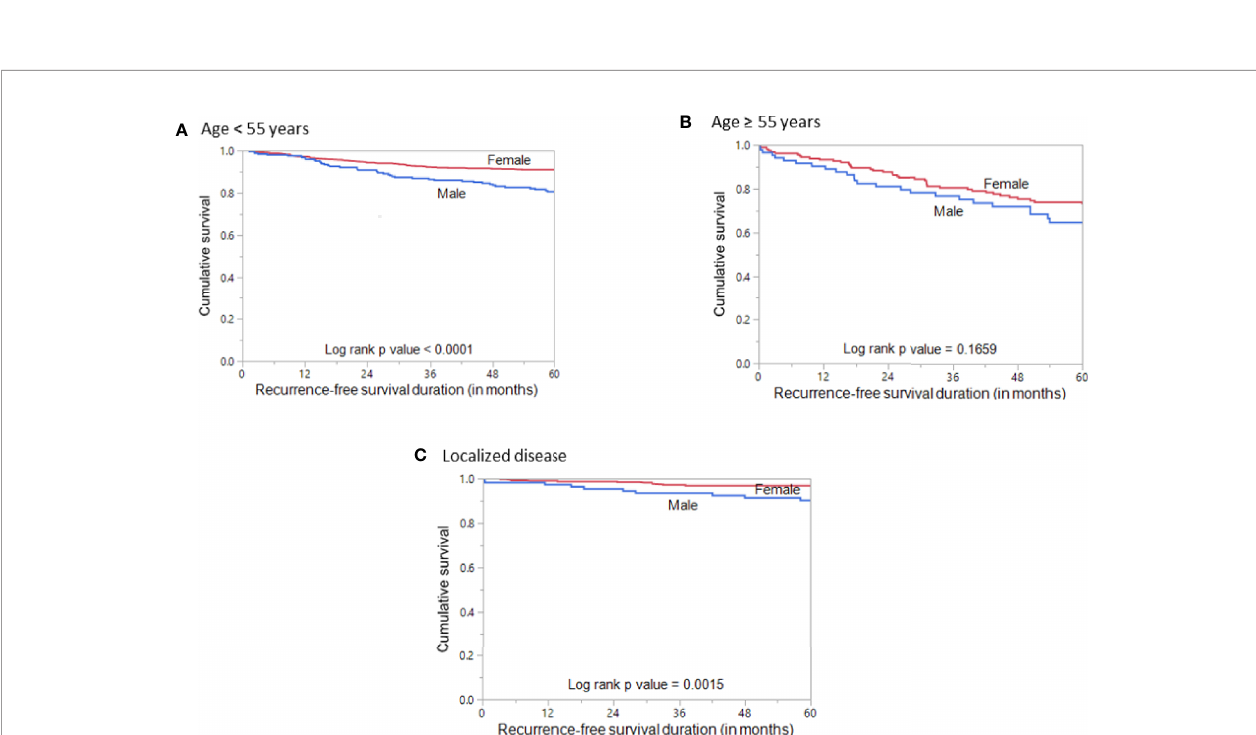
FIGURE 3 | Recurrence-free survival strati fi ed by age and disease localization. (A) Kaplan – Meier survival curve showing poor recurrence-free survival in male sex compared to female sex in patients aged < 55 years ( p < 0.0001). (B) Kaplan – Meier survival curve showing no signi fi cant difference in recurrence-free survival between male and female sex in patients aged ≥ 55 years ( p = 0.1659). (C) Kaplan – Meier survival curve showing poor recurrence-free survival in male sex compared to female sex in patients with localized PTC ( p =